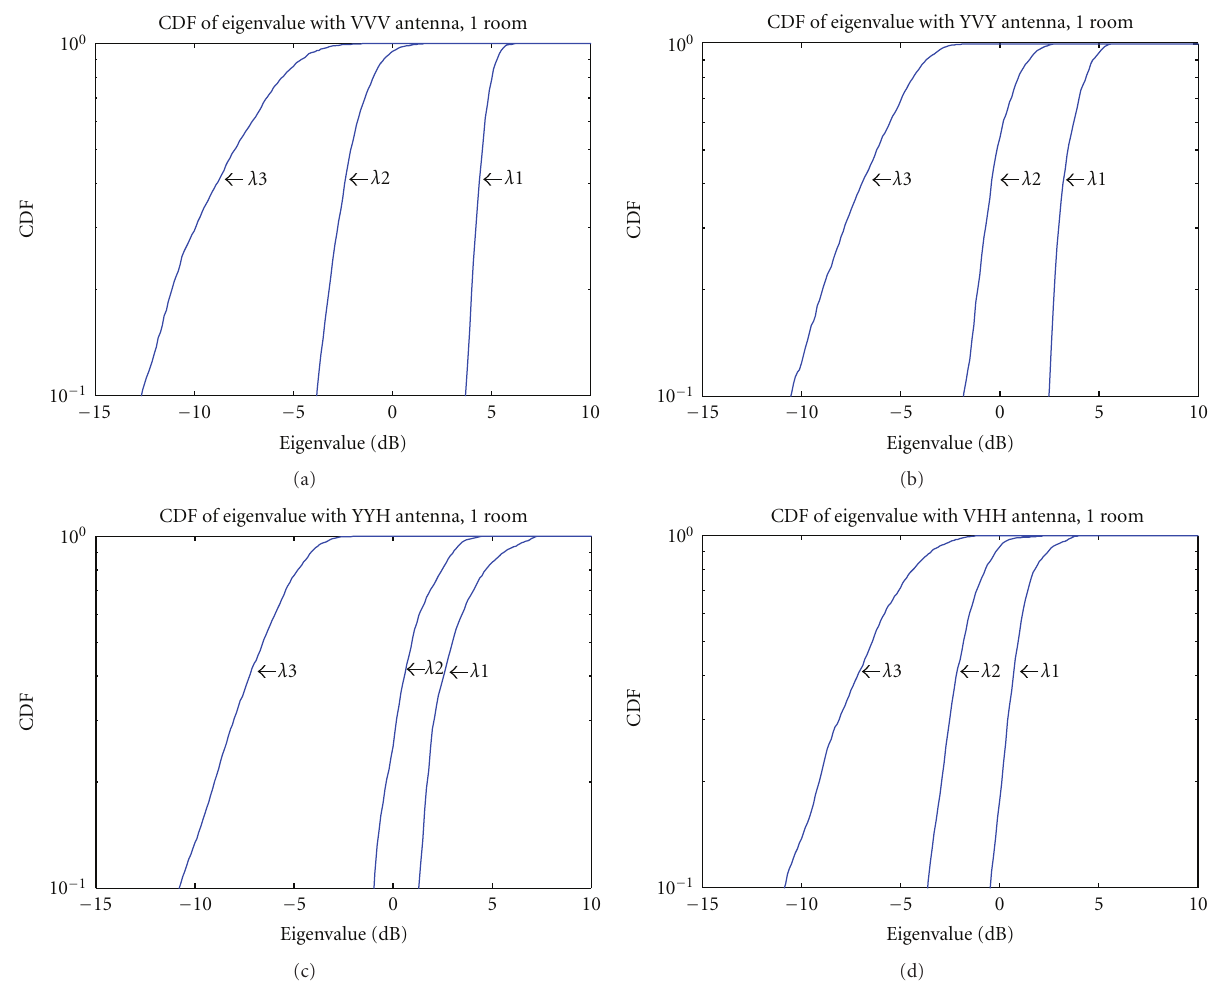
Figure 6: The plots of CDF versus eigenvalues when the polarization system employing (a) VVV, (b) YVY, (c) YYH, and (d) VHH cases in LOS indoor